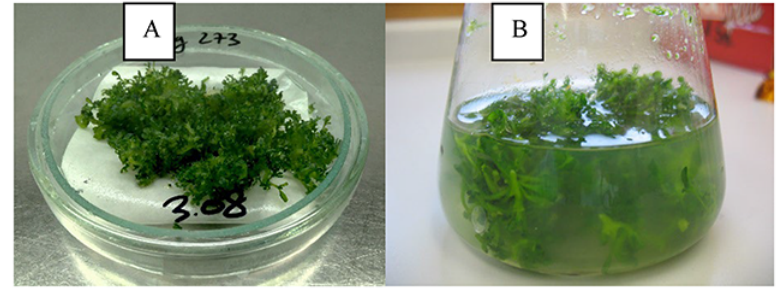
Figure 11 Ruta graveolens L. ( A ) stationary liquid and ( B ) agitated shoot